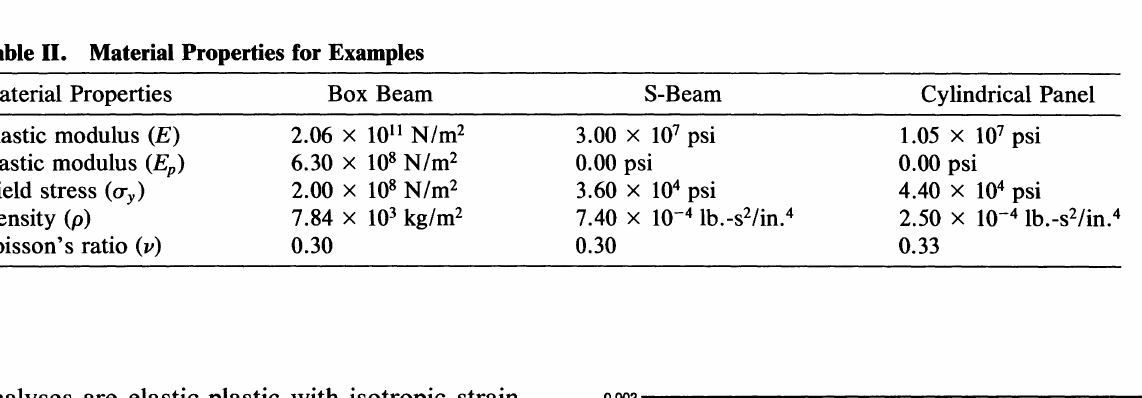
Table II. Material Properties for Examples Material Properties